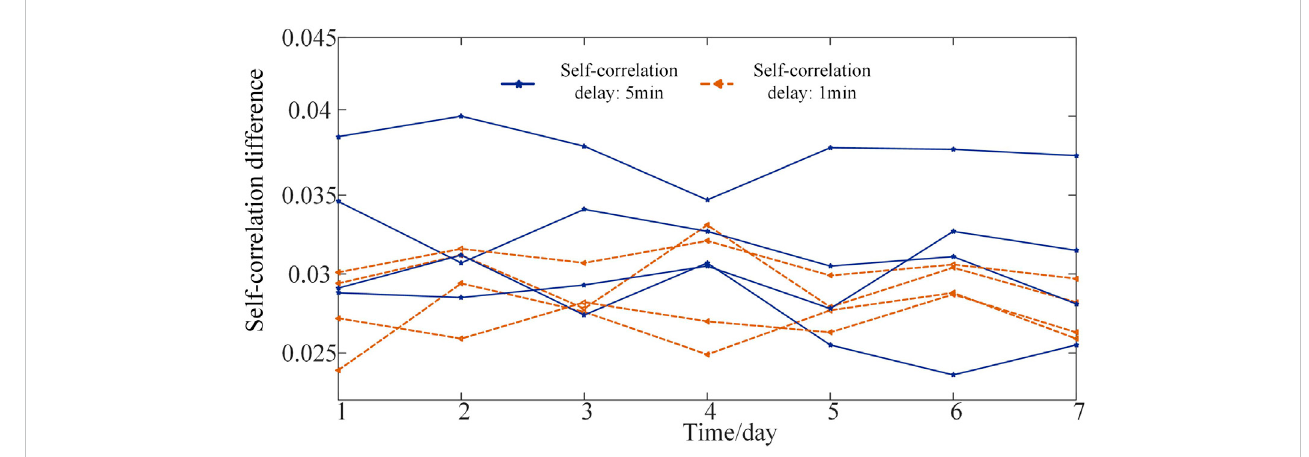
FIGURE 6 Self-correlation coef fi cient differences between unit output and wind speed.